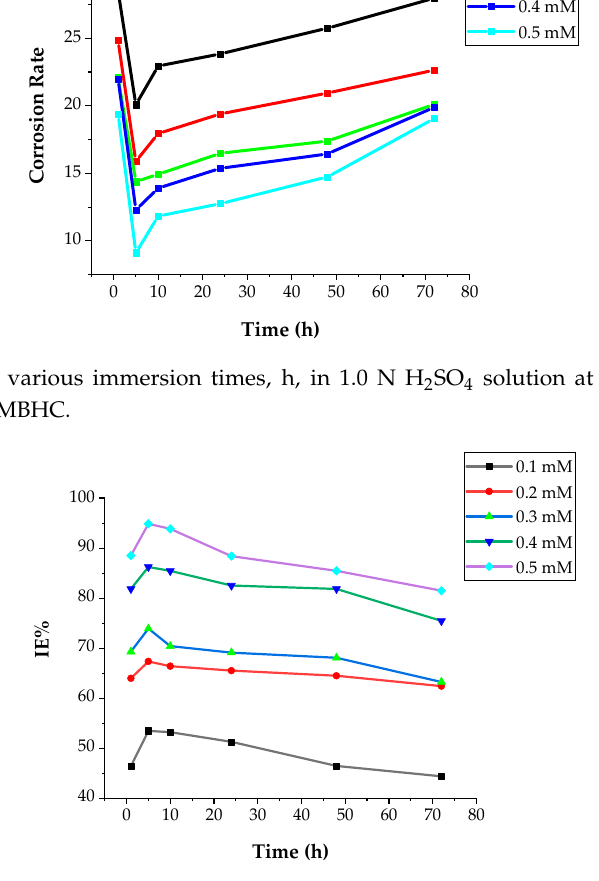
Figure 7. IE with various immersion times, h, in 1.0 N H 2 SO 4 solution at 30 °C with various concentrations of DMBHC.